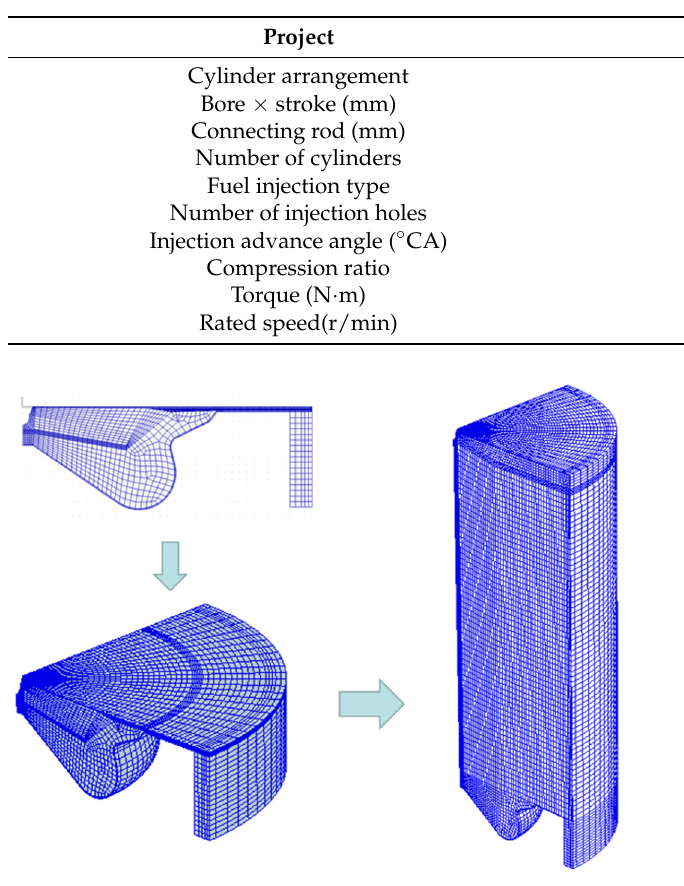
Table 1. Structural parameters of combustion chamber.